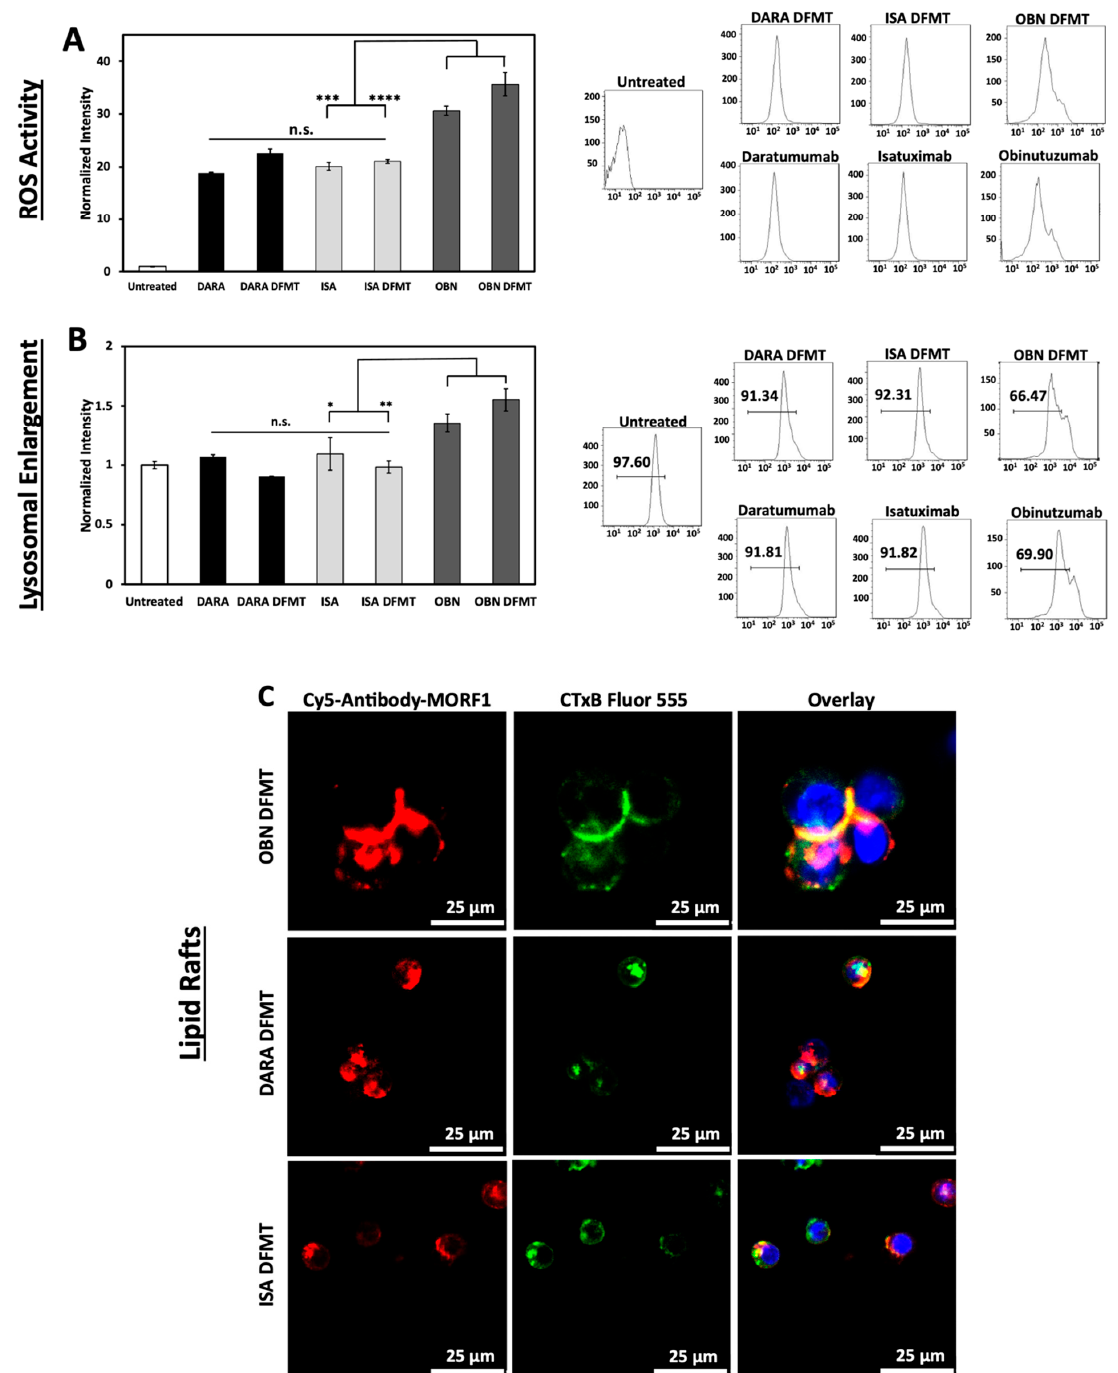
Figure 5. ( A ) Generation of ROS in DARA ‐ , ISA ‐ , and OBN ‐ based DFMT treated Raji cells. The ROS production was measured by oxidation of 2 ′ ,7 ′‐ dichlorodihydrofluorescein diacetate (H 2 DCFDA) and quantified with flow cytometry. ( B ) Lysosomal enlargement of DARA ‐ , ISA ‐ , and OBN ‐ based DFMT was quantified by LysoTracker Green DND ‐ 26 and flow cytometry. ( C ) Confocal microscopy was employed to observe any redistribution of CD38 receptors into cholesterol ‐ rich lipid rafts. Ab ‐ MORF1 (red); lipid raft marker: cholera toxin subunit B (CTxB) Alexa Fluor 555 (green). Nuclei were stained with Hoechst (blue). **** p < 0.0001, *** p < 0.001, ** p < 0.01, * p < 0.05, n.s. nonsignificant by One ‐ Way ANOVA and Tukey test.